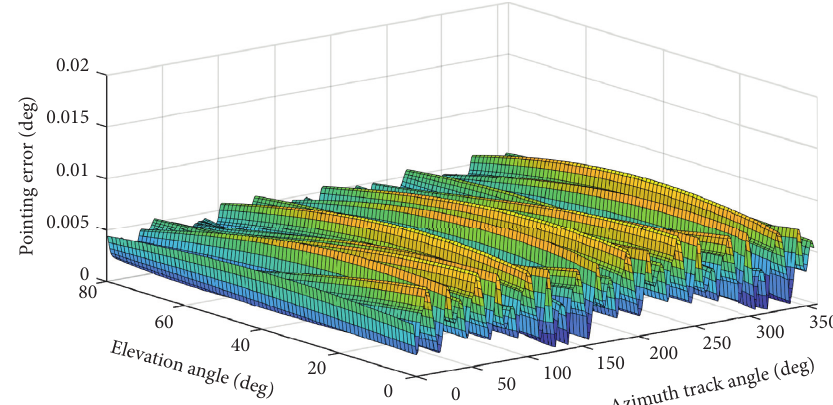
Figure 14: Telescope pointing error for the eight-support-point case.